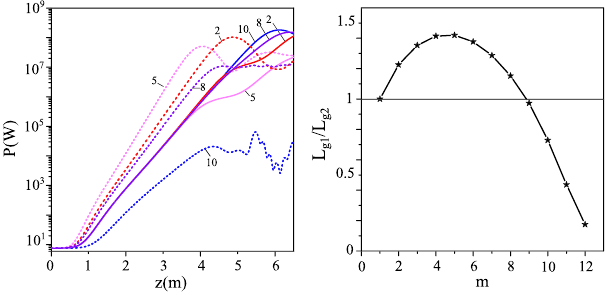
FIG. 3. (a) P ð W Þ as a function of the coordinate z ð m Þ along the undulator for m=n ¼ 2 (red curve), 5 (light magenta curve), 8 (violet curve), and 10 (blue curve). Solid line denotes x polarization; dashed line denotes y polarization. (b) L a function of m=n .